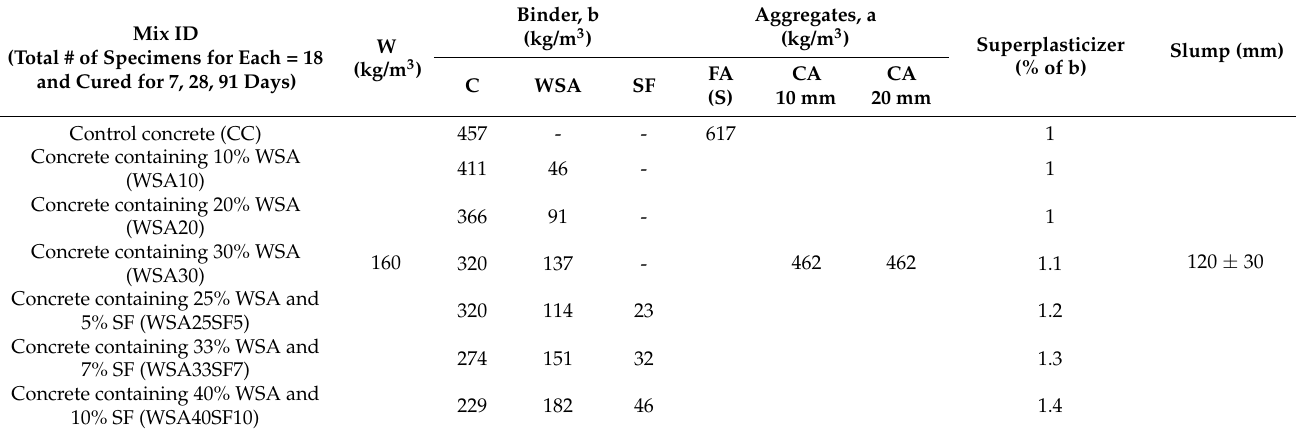
Table 3. Mixture proportions for control, binary, and ternary concretes (w/b = 0.35; a/b = 3.37; s/a =